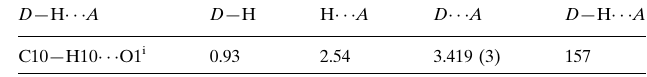
Hydrogen-bond geometry (A˚ , (cid:4)